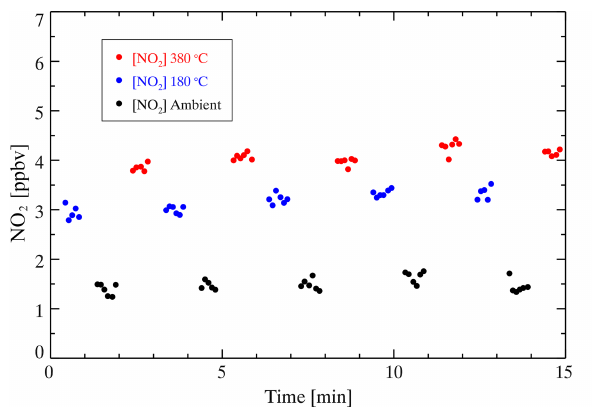
Figure 5. An example of typical measurements performed in a field study with a 6s spectrum integral time. A measurement cycle in- cludes three phases whose duration is 60s. The red points denote the NO 2 mixing ratio measured in the AN channel ([NO 2 ] 380 ◦ C), the blue points denote the NO 2 mixing ratio measured in the PN channel ([NO 2 ] 180 ◦ C), and the black points denote the NO 2 mix- ing ratio measured in the reference channel ([NO 2 ] ambient tem-